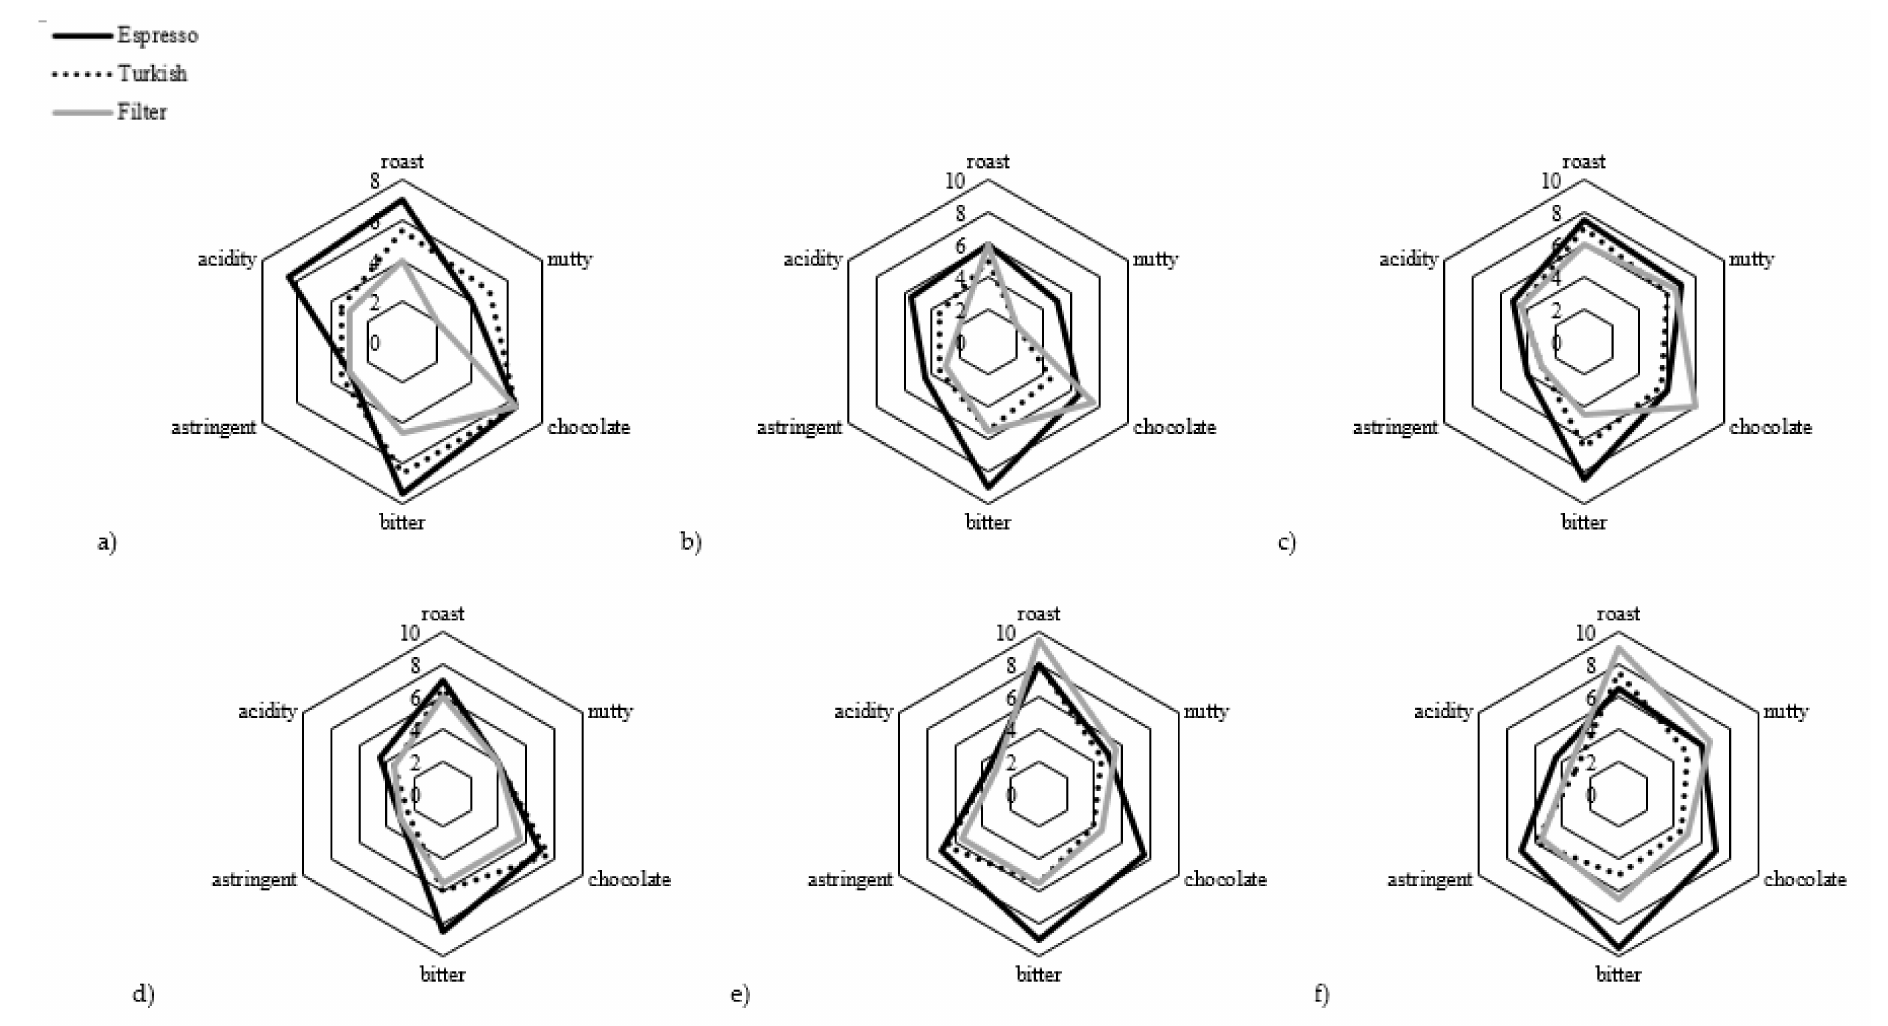
Figure 3. Results of the sensory evaluation of differently prepared coffee brews of ( a ) RC_1; ( b ) RC_2; ( c ) RC_3; ( d ) RC_4; ( e ) RC_5; ( f )